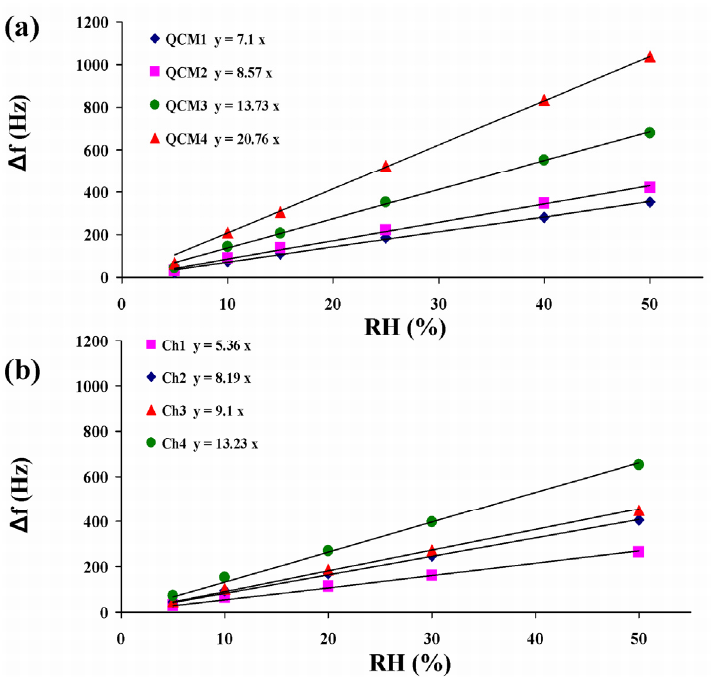
Figure 7. Responses of the QCM sensors (a) and MQCM channels (b) vs. relative humidity variation. Data are fitted by straight lines with angular coefficients representing the sensitivity of each sensor, see (2).